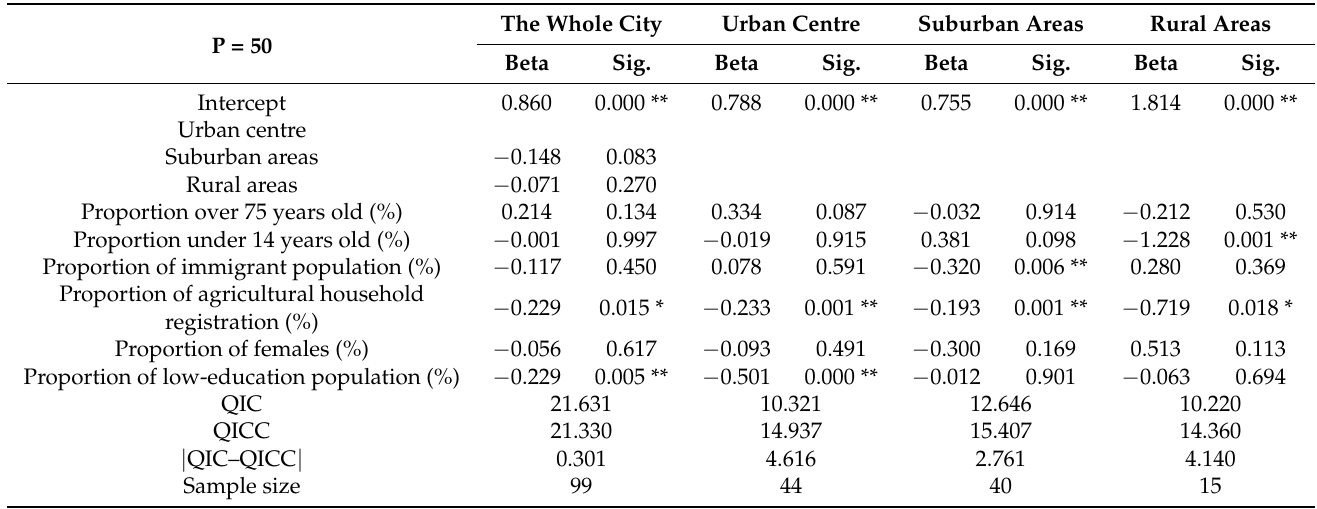
Table 6. GEEs for predicting the area of the flooded proportion over 50 years with respect to the vulnerable groups. P =